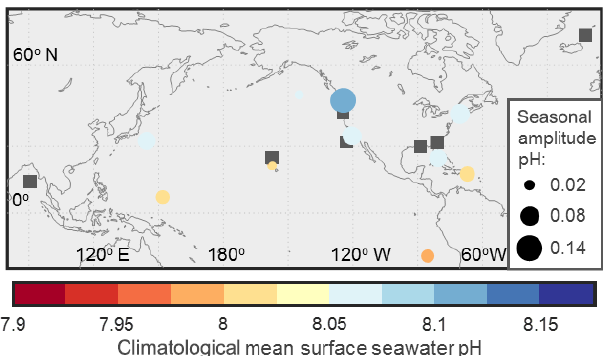
Figure 2. Location of 17 moored pH time series. Circle color repre- sents climatological mean seawater pH and size of circle represents seasonal amplitude. Gray squares show the locations of moored pH time series where the lack of seasonal distribution of measurements prevent the calculation of climatological mean or seasonal ampli- tude. No pH time series are of sufficient length to estimate the IAV as presented for seawater p CO 2 in Fig. 1.